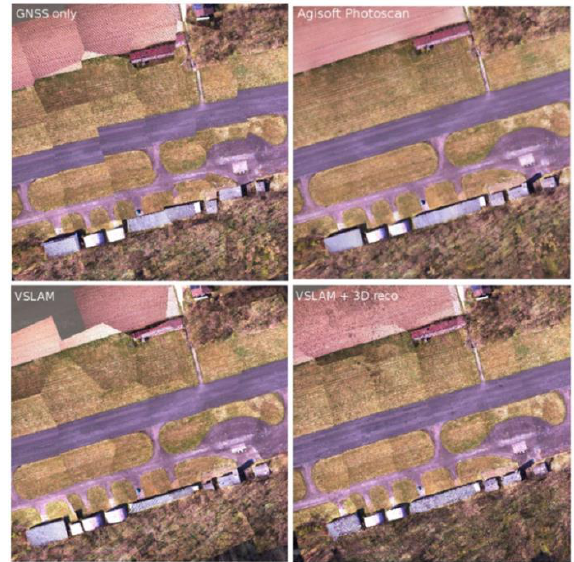
Figure 9: A comparison of results achieved using visual mapping